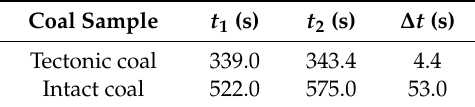
Table 3. Critical time of tectonic and intact coal during each